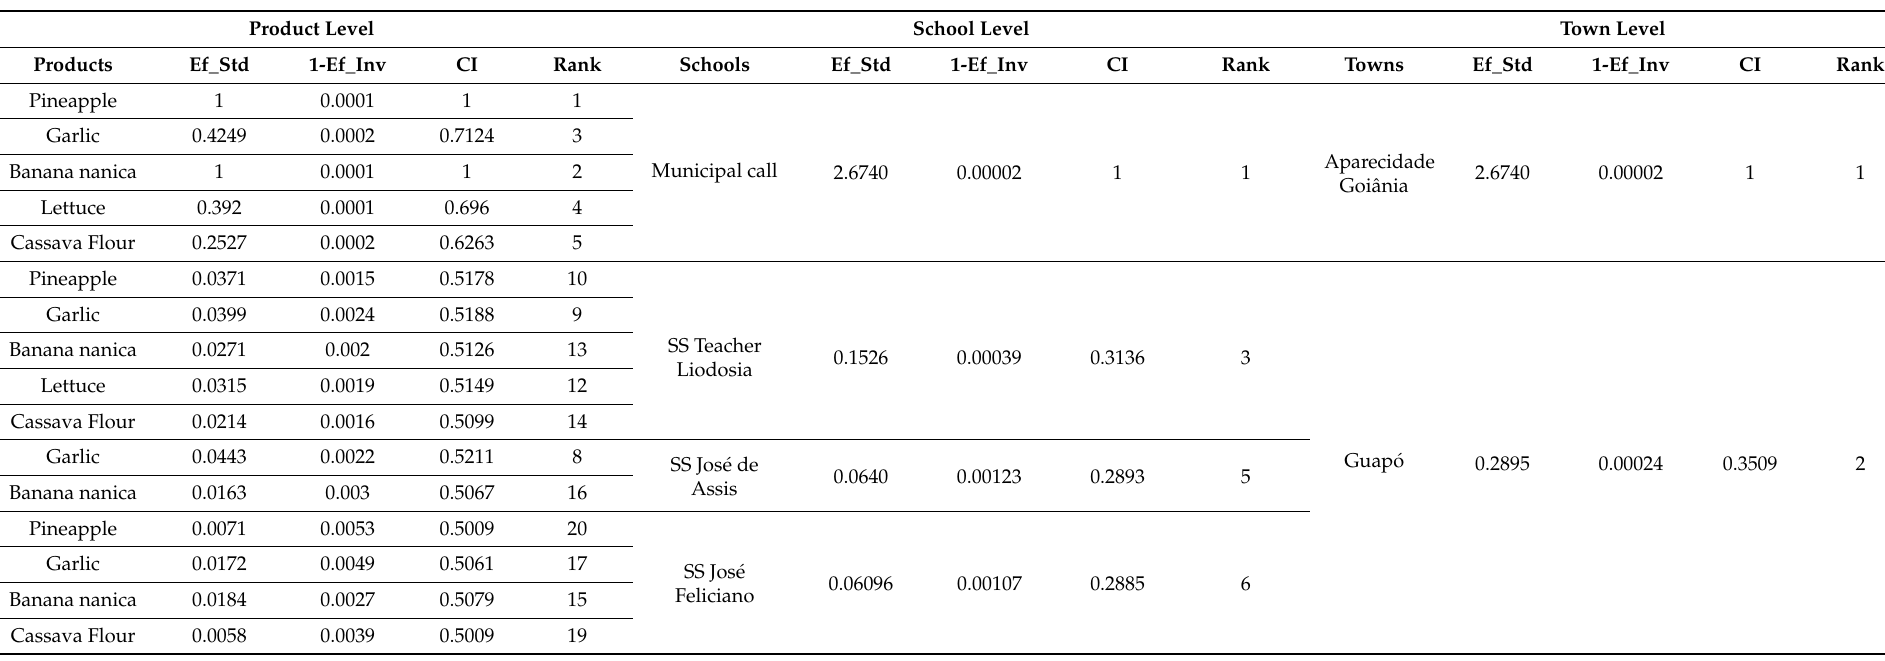
Table 2. Results of DEA model, including the standard efficiency ( Ef_Std ), the inverted efficiency ( Ef_Inv ), the composite index ( CI ), and the final rank. Product